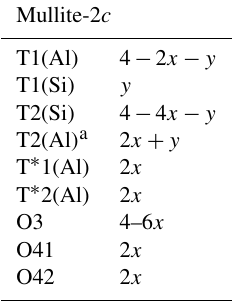
Table 5. Site occupancies of mullite-2 c expressed in apfu as a func- tion of the x value. y is the amount of Si shifted from T2 to T1 position, causing slight additional disorder on the T sites.